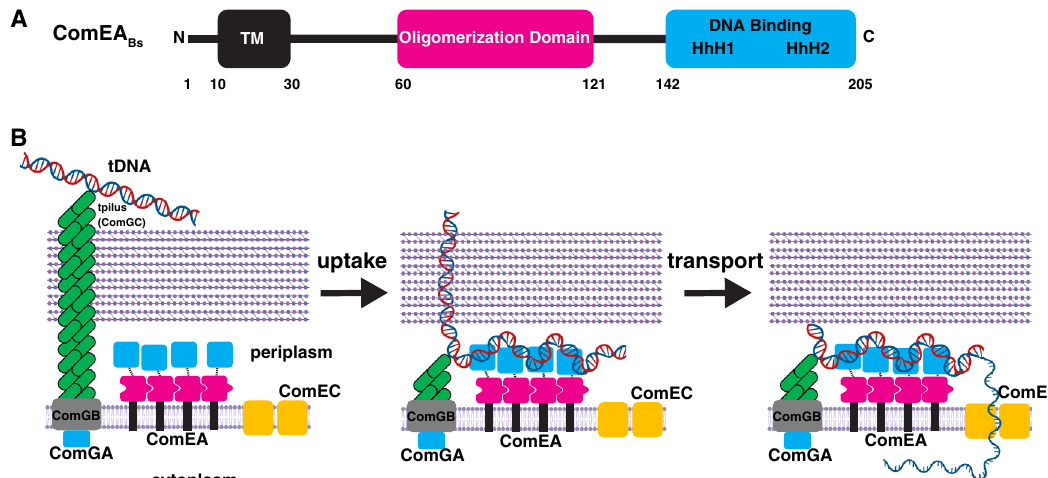
Fig. 8 | ComEA Bs domain architecture, and proposed model of genetic trans- formation in Gram-positive bacteria. A ComEA Bs contains an N-terminal trans- membrane region, a previously unidenti fi ed OD, and a C-terminal DNA-binding domain. B We have shown that ComEA self-associates using contacts in its ODs. After retraction of the tpilus to bring a loop of DNA into the periplasm, binding of